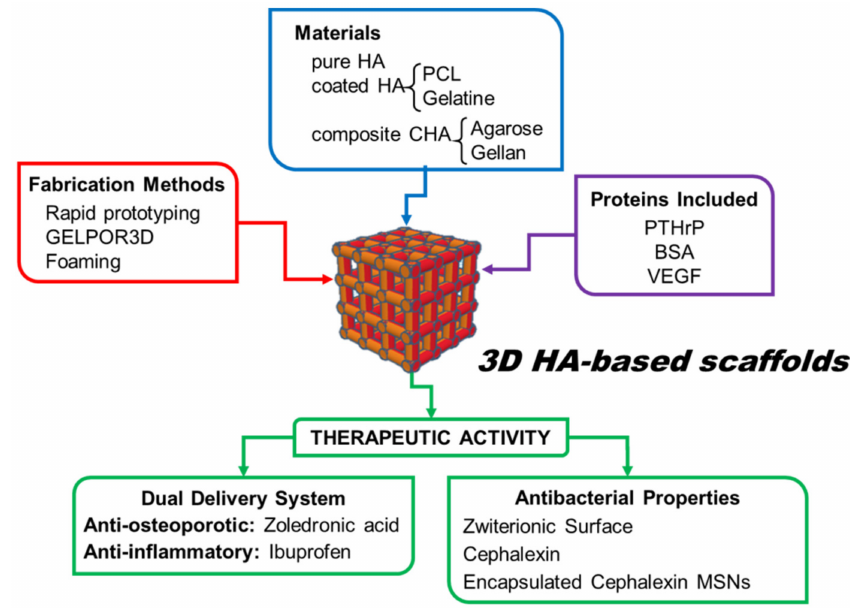
Figure 4. Strategies carried out in the fabrication of engineered HA-based